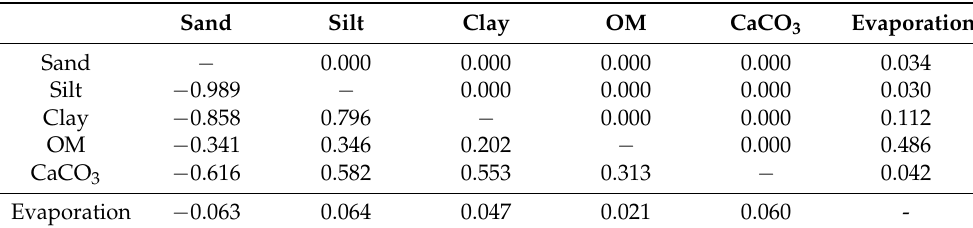
Table 5. Spearman correlation coefficients (r, below diagonal) and significance ( p , above diagonal) among soil properties. OM: organic matter. Sand Silt Clay OM CaCO 3 Evaporation Sand − 0.000 0.000 0.000 0.000 0.034 Silt − 0.989 − 0.000 0.000 0.000 0.030 Clay − 0.858 0.796 − 0.000 0.000 0.112 OM − 0.341 0.346 0.202 − 0.000 0.486 CaCO 3 − 0.616 0.582 0.553 0.313 − 0.042 Evaporation − 0.063 0.064 0.047 0.021 0.060 - Median of the RFRs involving all variables (‘all’) model indicated 69.9% explained variance, with MAE of 112 mm (RMAE: 34%). Variable importance was the following in